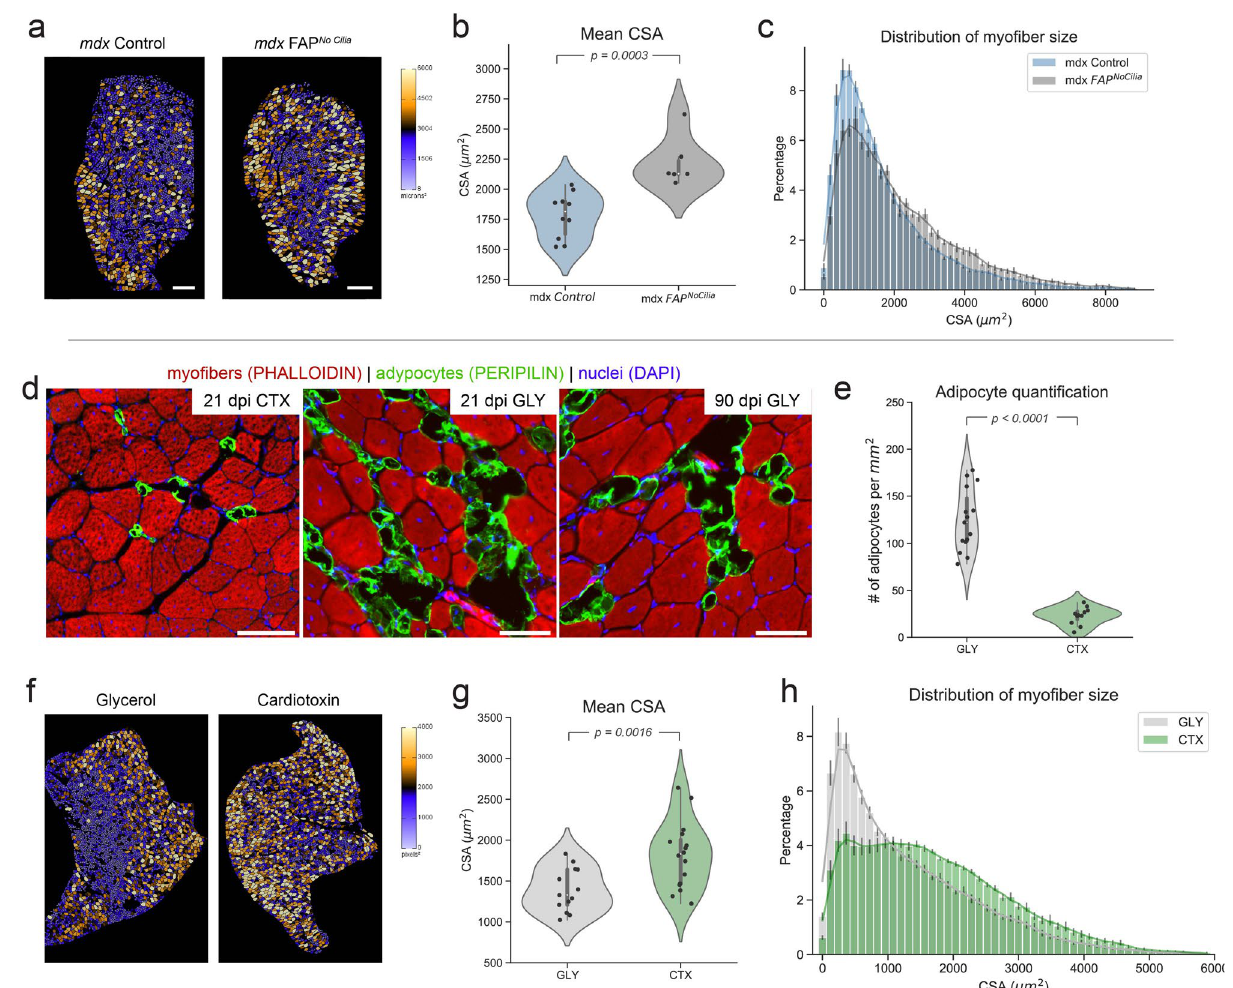
Figure 8. Cellpose and LabelsToROIs enable the quantification of CSA across different disease and injury settings. Top Re-quantification of data from Kopinke et al., 2017. ( a ) TA images from 10- to 12-month-old NoCilia mdx control and mdx FAP mice stained for Laminin were re-analyzed using Cellpose. LabelsToROIs was used to erode the segmentations according to visual inspection (5 pixels). Myofiber segmentations were color-coded based on their CSA using the FIJI/ImageJ ROI color coder. Scale bar, 500 μm. ( b ) Mean CSA of NoCilia mdx control (n=10) and mdx FAP mice (n=6). Statistical differences were assessed by a Student T test. NoCilia ( c ) Distribution of myofiber CSA for mdx control and mdx FAP mice. Results are presented as means standard error of the mean (SEM) for each bin and each genotype. Bottom CSA comparisons between injury types. ( d ) Few adipocytes, marked by PERILPIN (green), have formed 21 days post muscle injury caused by cardiotoxin (CTX). In contrast, glycerol-induced injury (GLY) causes massive fat infiltration that persists up to 3 months. Myofibers are labeled with Phalloidin (red) and nuclei with DAPI (blue). ( e ) Number of adipocytes 2 per mm of injured area 21 days post GLY (n=15) or CTX (n=11) injury. Statistical differences were assessed by a Student T test. ( f ) Cellpose and LabelsToROIs were used to segment and process TA images stained for Laminin corresponding to GLY and CTX treated mice. Myofiber segmentations were color-coded based on their CSA using the FIJI/ImageJ ROI color coder. ( g ) Quantification of the mean CSA of myofibers 21 days post GLY (n=12) or CTX (n=18) injury. Statistical differences were assessed by a Student T test. ( h ) Distribution of myofiber size for each injury. Results are presented as means standard error of the mean (SEM) for each bin and each little fat, to a glycerol (GLY) injury in CD1 wild type mice, which also elicits a regenerative response but results in massive fat infiltration 5,6,11,28,48–50 . Confirming the differences in fat formation between these two injuries, 2 we detected few PERILPIN + fat cells 21 days post CTX injury (Fig. 8d) with around 25 adipocytes per mm of injured area (Fig. 8e). In contrast, GLY induced five times as much adipocyte differentiation as CTX, which persisted for up to 3 months post-GLY injury (Fig. 8d,e). We then asked if there is a difference in the regenera- tive response of myofibers between CTX and GLY at 21 days post-injury. Again, using Cellpose and our Label- sToRois plugin to automatically segment and quantify myofibers stained for Laminin, we found that myofibers recovered more efficiently after a CTX injury compared to GLY (Fig. 8f,g). In fact, we noticed that a large major- ity of myofibers remained small compared to myofibers after a CTX injury (Fig. 8h). Thus, GLY causes massive